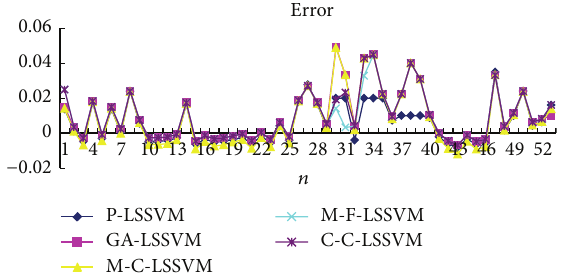
Figure 12: Five models predicted error diagram for FM broadcast- ing band.